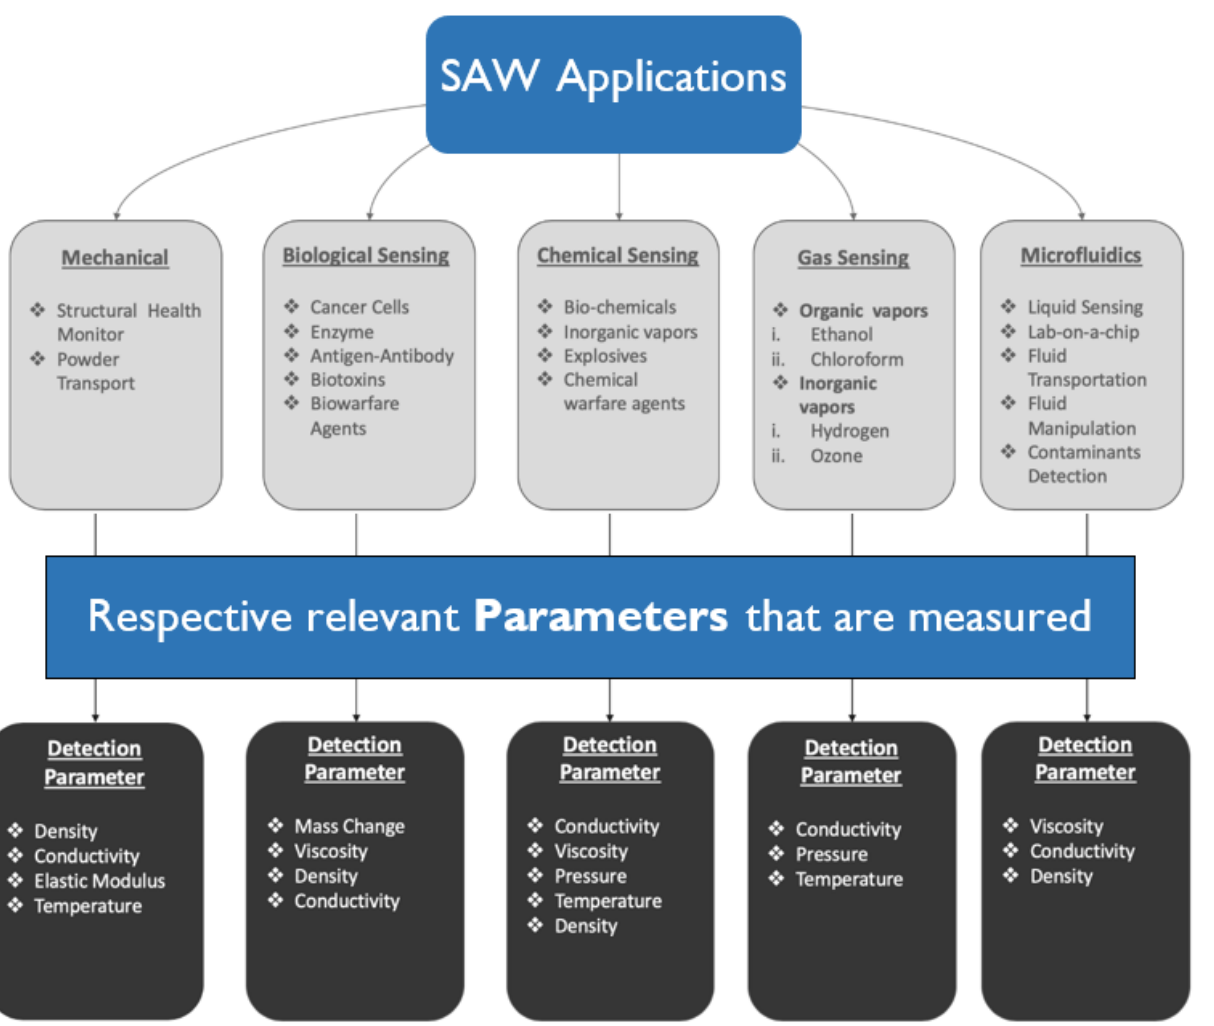
Figure 1. Classification of SAW applications and their detection parameters.